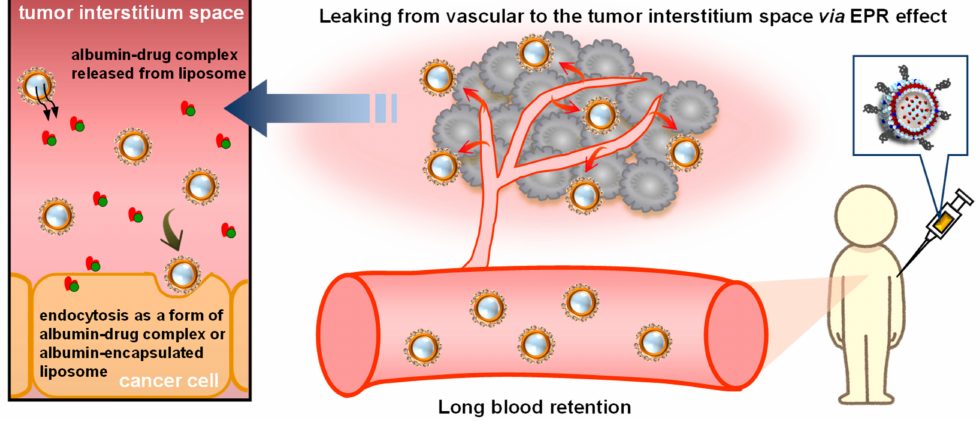
Figure 5. Scheme for the targeting mechanism of albumin-encapsulated liposomes to solid cancers.